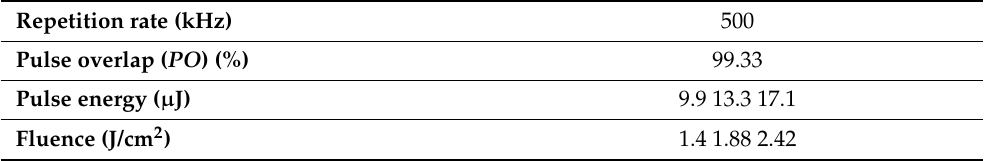
Table 2. Laser parameter variations used for copper and steel